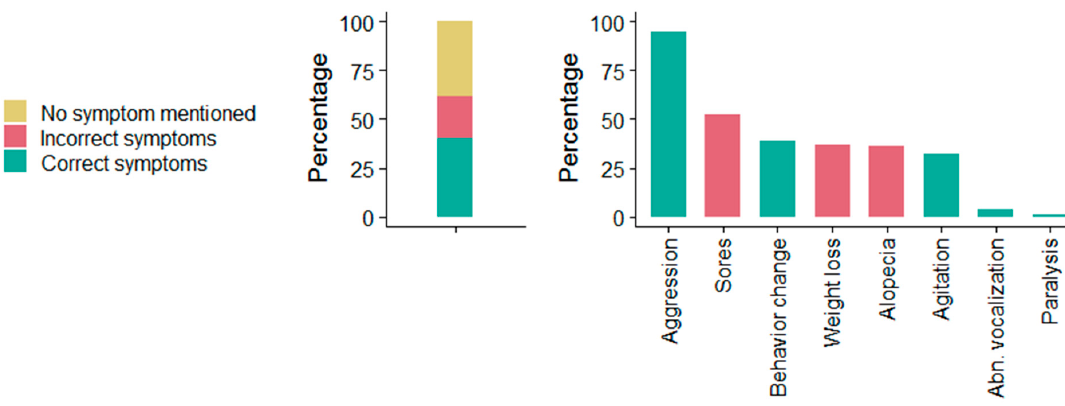
Figure 3. Animal rabies symptoms mentioned by the study participants in Matadi, Democratic Republic of the Congo (DRC) in May 2017. The left plot displays the proportion of respondents that did not mention any rabies symptoms and the proportion of respondents that stated correct and incorrect symptoms. The right plot displays frequently mentioned correct and incorrect animal rabies symptoms.